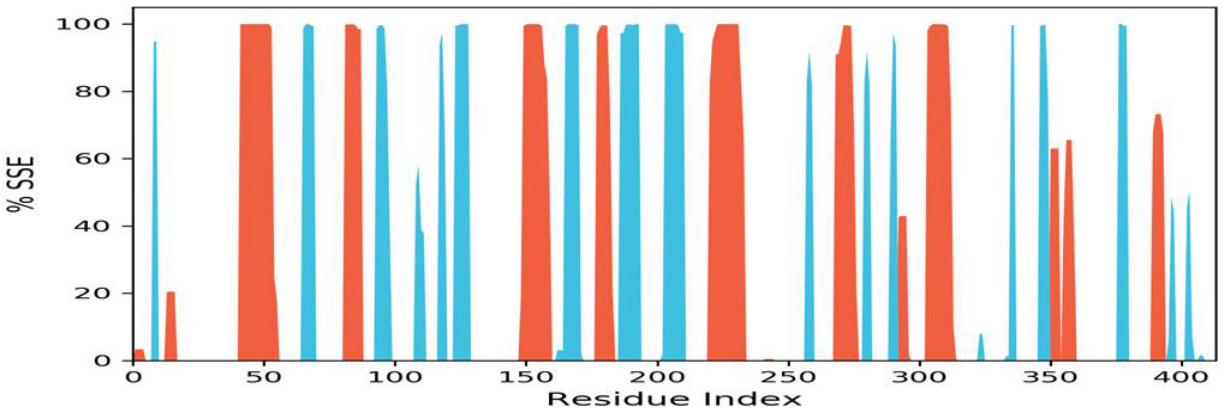
Figure 7. Secondary structure elements (SSE), white color—loops, red color—helix regions, turquoise color—strands in the protein.